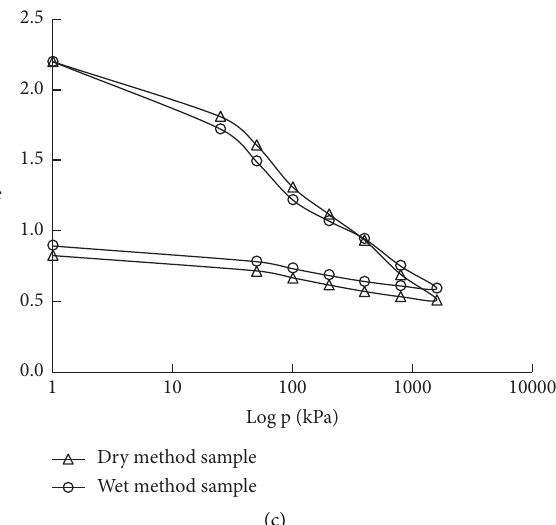
Figure 6: Compression and rebound curves of different samples in the e-log p coordinate. (a) Wet method samples; (b) dry method samples; (c) average curve comparison.